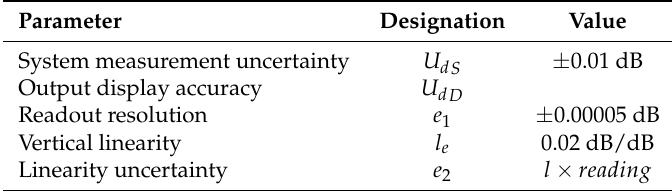
Table 7. Design stage uncertainty analysis on the TFS 3031, Tektronix Optical Time Domain Reflectometry (OTDR) unit used for experimental OTDR measurements